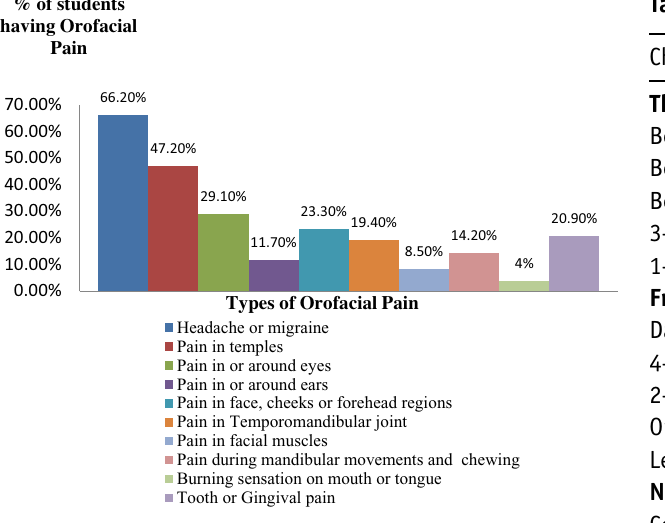
Fig. 1. Prevalence of different types